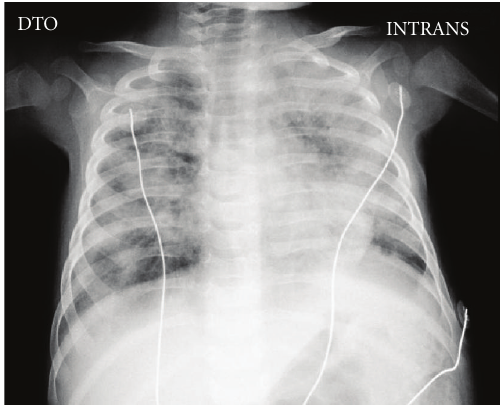
Figure 1: Chest X-ray.